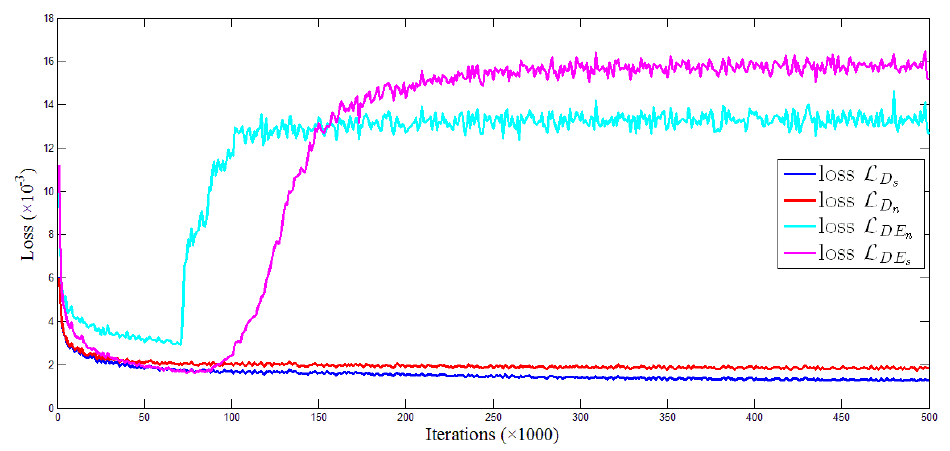
Figure 2. Plot of losses on training the proposed